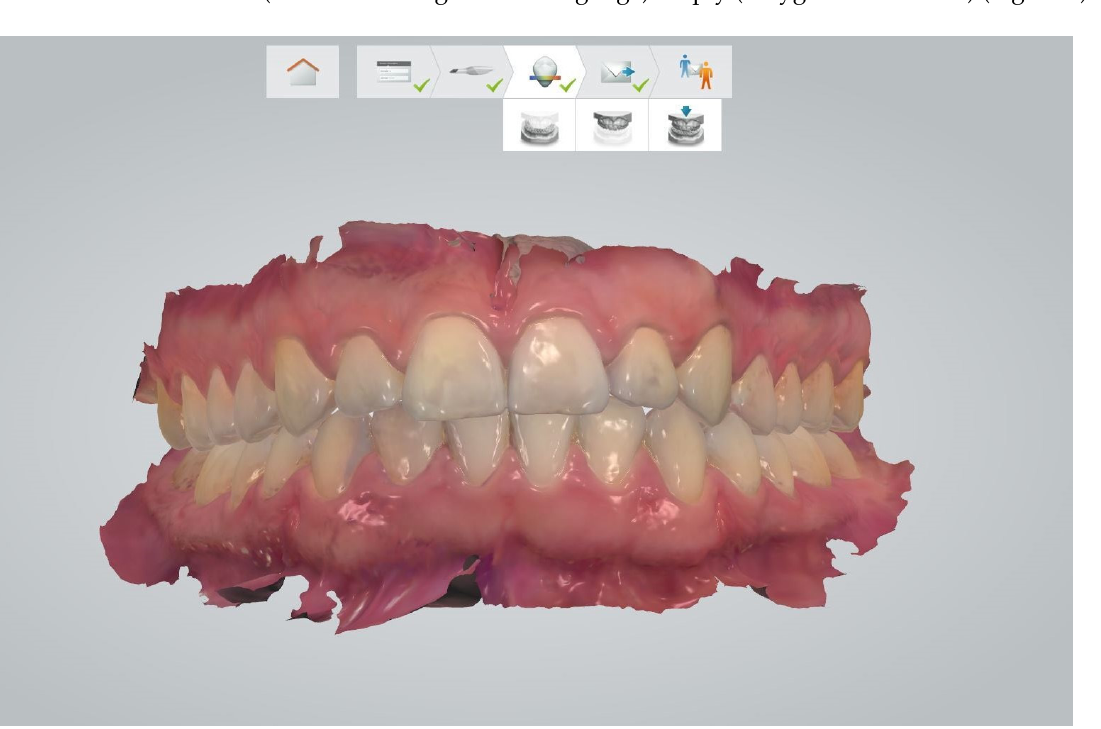
Figure 2. Face scan with closed mouth.